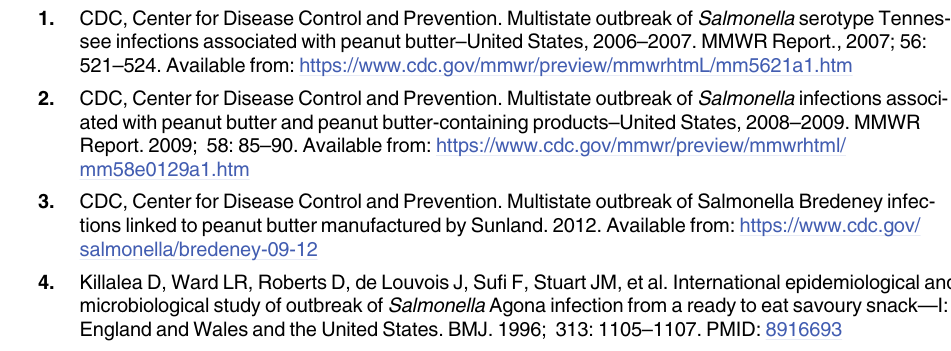
S4 Table. Salmonella count in peanut confectionary product inoculated with high inocu- lum level and stored for 420 days. S5 Table. Salmonella count in peanuts inoculated with low inoculum level and stored for 420 days. S6 Table. Salmonella count in peanuts inoculated with high inoculum level and stored for 420 days. S7 Table. Water activity (mean value of four samples) of the peanut products inoculated with tow inoculum levels and stored for 420